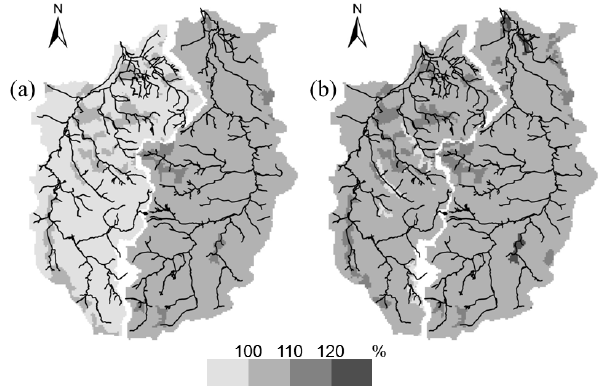
Fig. 3. Ratio between annual actual evapotranspiration for the sce- narios and the reference period (a) scenario A, (b) scenario B.